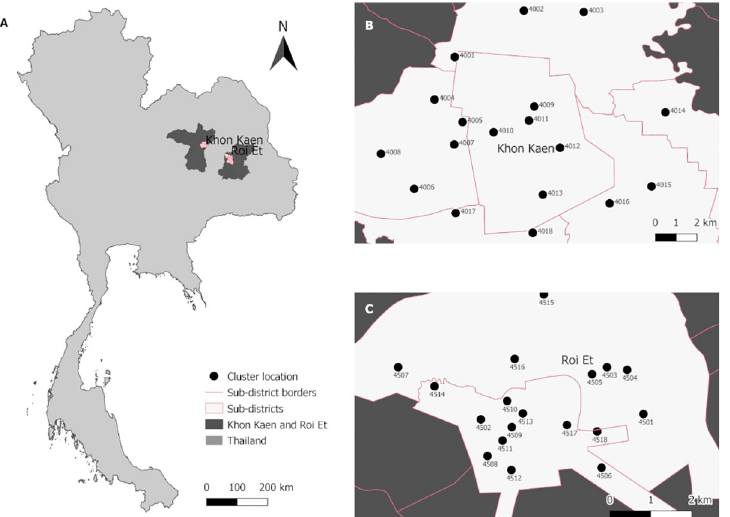
Fig 1. Map of study sites. (A) represents Thailand and the provinces of Roi Et and Khon Kaen. (B) shows the location of the 18 clusters numbered from 4001 to 4018 in the city of Khon Kaen (KK Mueang District). (C) shows the location of the 18 clusters numbered from 4501 to 4518 in the city of Roi Et (RE Mueang District). Map of study sites was built using QGis 3.10 software and shapefiles were obtained from the Humanitarian Data Exchange project [49] under the Creative Commons Attribution International 4.0 license (CC BY